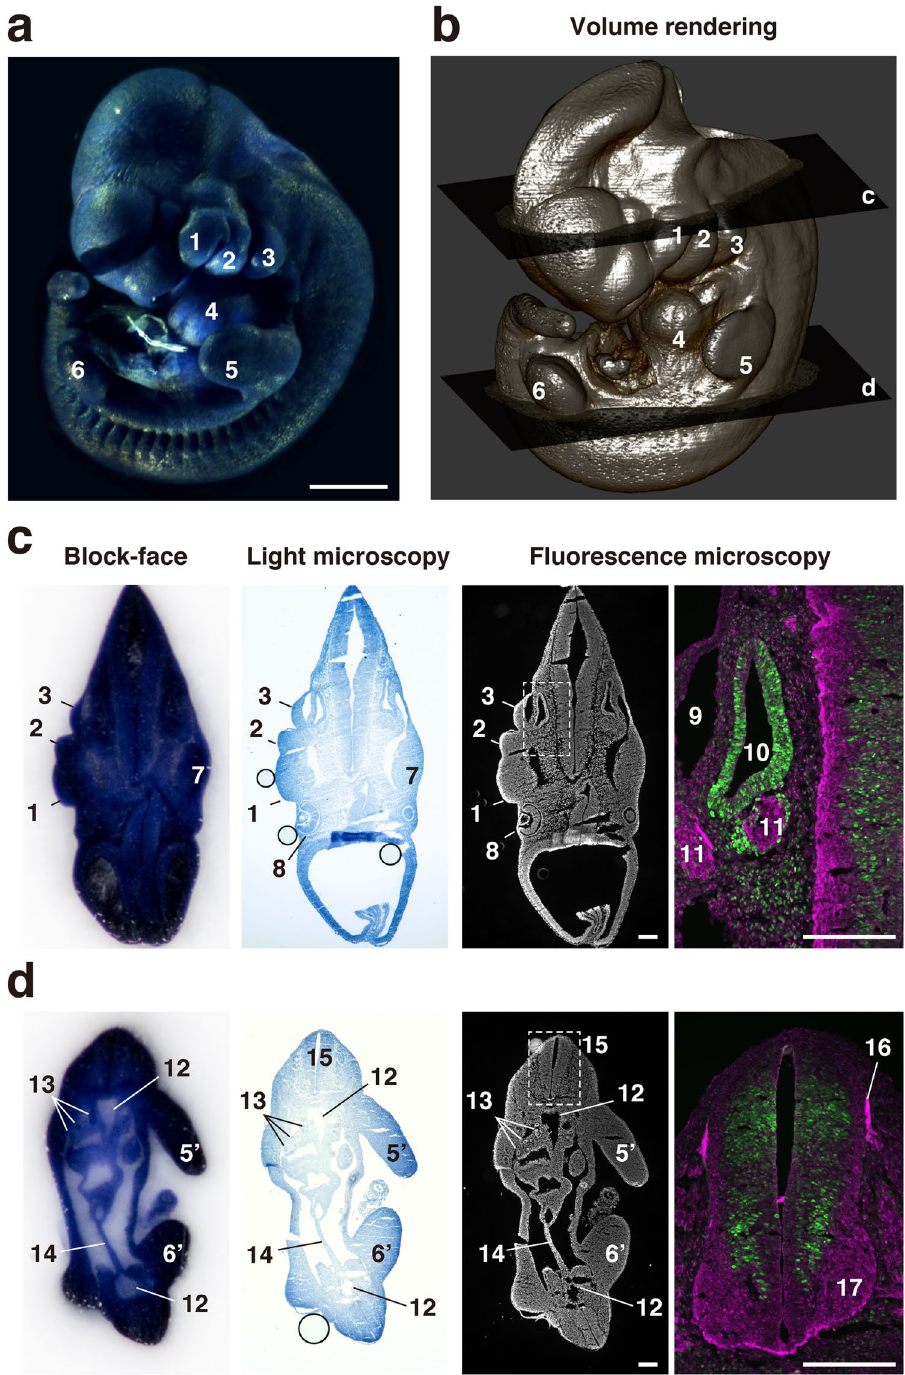
Figure 3. Correlation between 2D images and volume rendering image of E10.5 mouse embryo. ( a ) An E10.5 mouse embryo was prestained with hematoxylin and examined using the CoMBI technique. ( b ) Volume rendering image was reconstructed from 503 block-face images to show the surface structures of the mouse embryo. ( c , d ) At the planes c and d in ( b ), frozen sections were collected and fluorescently labeled for nuclei, cyclin D1, and VAMP2. The block-face images are shown in the rightmost column. The sections were examined by light microscopy, and showed nuclei prestained with hematoxylin. The sections were also examined by fluorescence microscopy, and showed nuclei labeled with DAPI. Distributions of VAMP2 ( a marker of synaptic vesicles, green) and cyclin D1 (cell cycle marker, magenta) are shown at higher magnification. 1: maxillary process, 2: mandibular arch, 3: hyoid arch, 4: heart, 5: left forelimb, 5 ′ : right forelimb, 6: left hindlimb, 6 ′ : right hindlimb, 7: trigeminal ganglion, 8: eye, 9: primary head vein, 10: otic vesicle, 11: facioacoustic ganglion complex, 12: dorsal aorta, 13: mesonephros, 14: mesentery, 15: neural tube, 16: dorsal root, 17: ventral horn. Bars in a: 1 mm, c, d: 200 µ